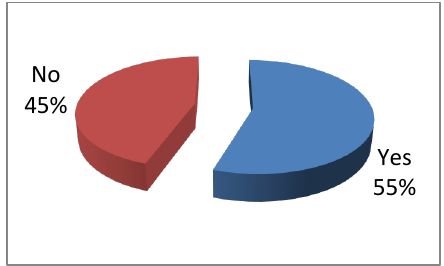
Figure 2: Awareness of local tourist